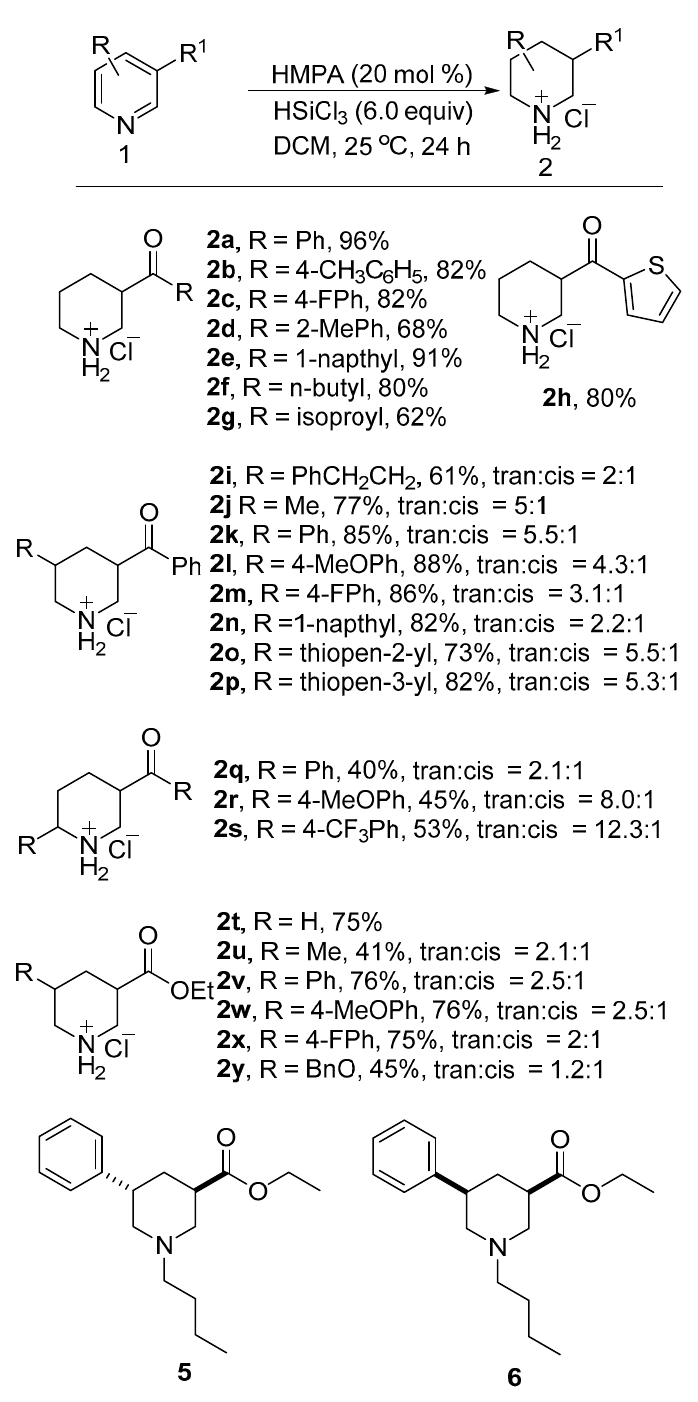
Figure 2. Substrate scope of the HMPA-catalyzed reduction of pyridines.